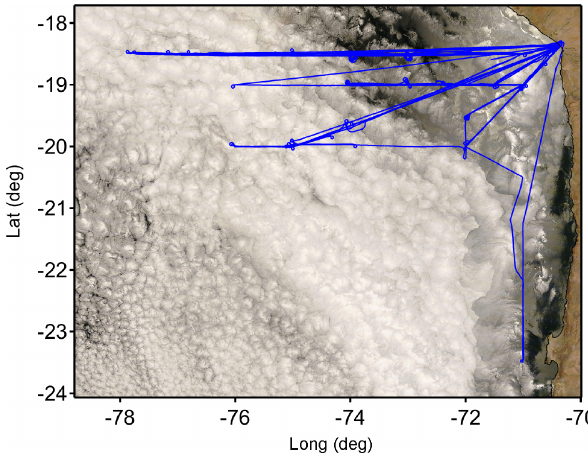
Figure 1. Composite flight tracks of the DOE G-1 during 2008 VOCALS-REx overlaid on a Terra image taken at 16:50, 12 Novem- ber